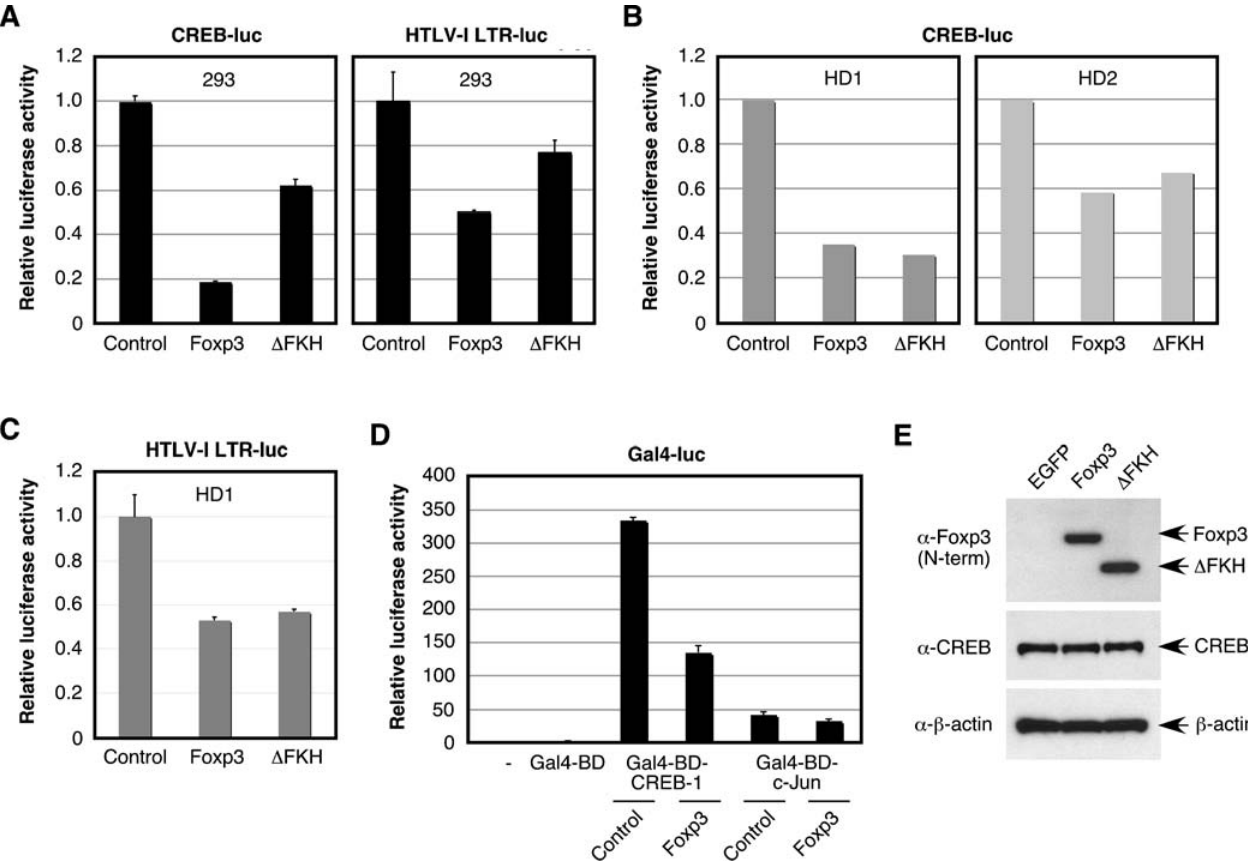
Figure 6. Foxp3 Inhibits CREB-Dependent